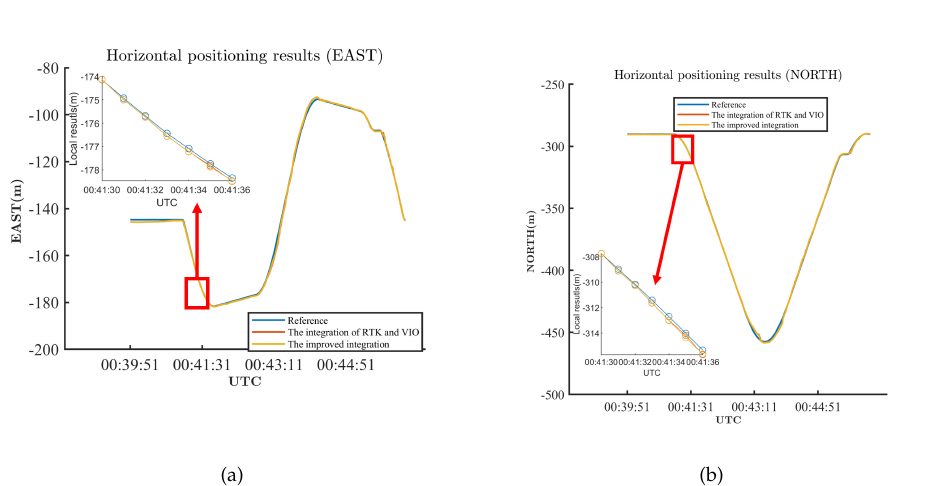
Figure 17. Horizontal positioning results. ( a ) The positioning results in east. ( b ) The positioning results in